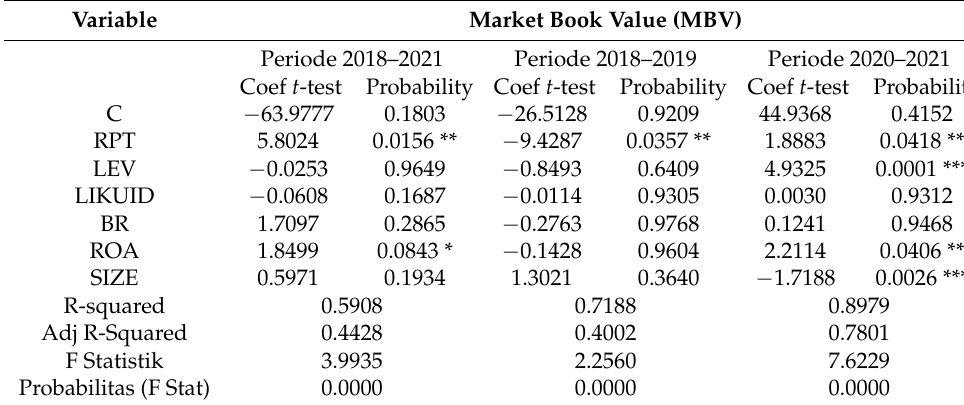
Table 6. Robustness